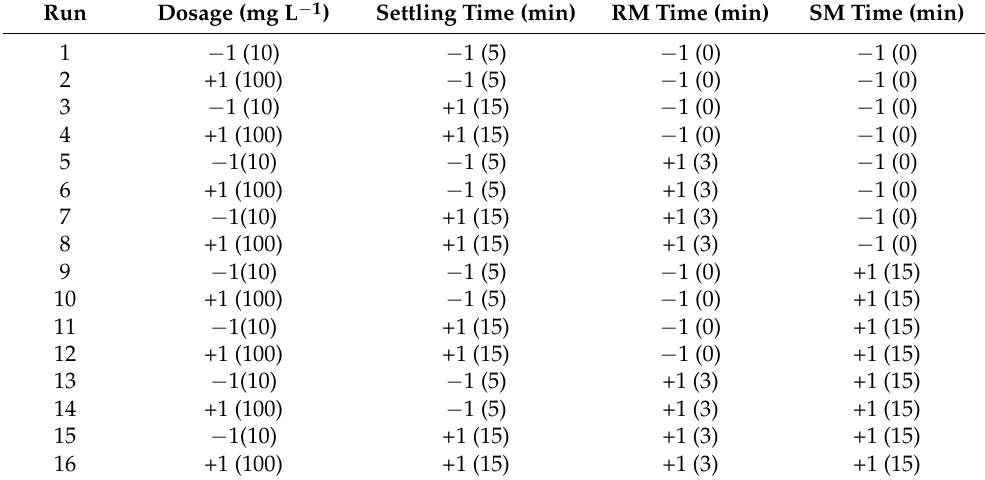
Table 1. Experimental design data for optimizing C. vulgaris harvesting with Zetag 8185 (coded levels and real values in